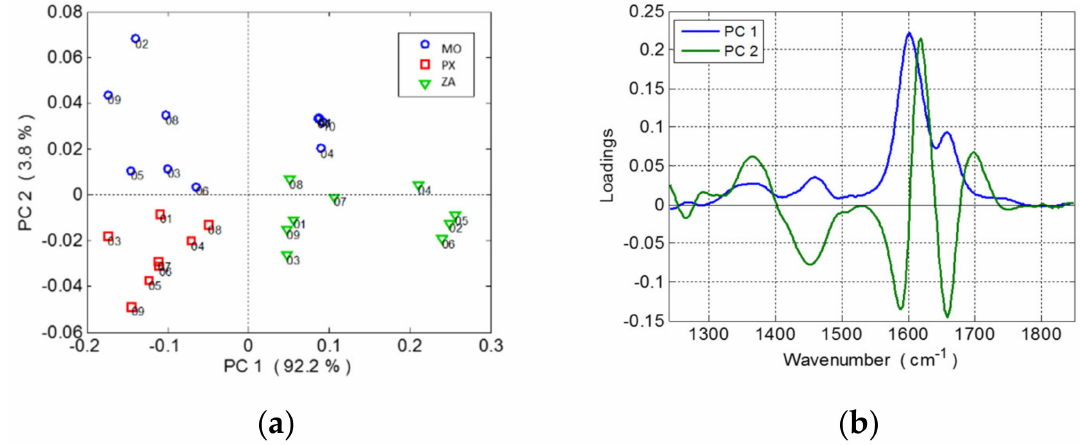
Figure 2. ( a ) Score plots of the principal component analysis (PCA) (first two principal components) for clustering grape seeds according to the grape variety (MO: Moscatel, PX: Pedro Xim é nez, ZA: Zalema). ( b ) PC1 and PC2 loading